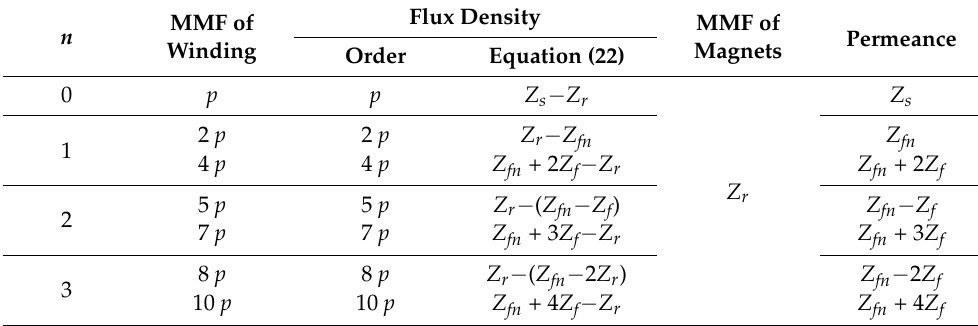
Table 3. Summarization of main harmonics for non-uniform tooth